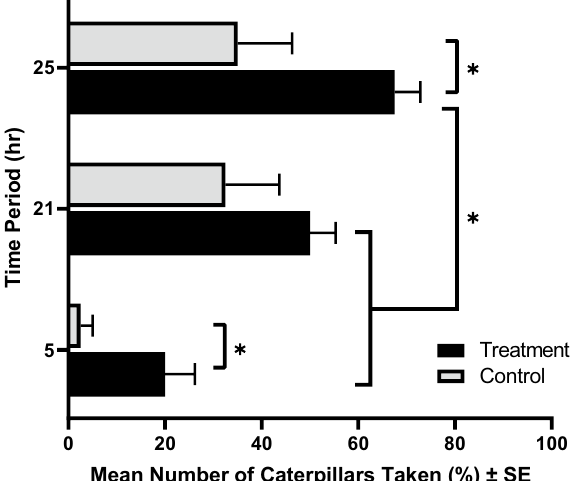
Figure 1. Effect of malathion on predation of monarch ( D. plexippus ) caterpillars. The rate of predation by aerial predators on monarch caterpillars (N = 4 per plant and N = 160 total) feeding on host plants treated with malathion was assessed at 5, 21 and 25 h after treatment. None of the caterpillars on host plants under mesh laundry hampers were predated. Bars indicate the mean number of caterpillars killed or taken by treatment group. Asterisks indicate significant differences between groups, using GLM with Poisson distribution ( p < 0.05).